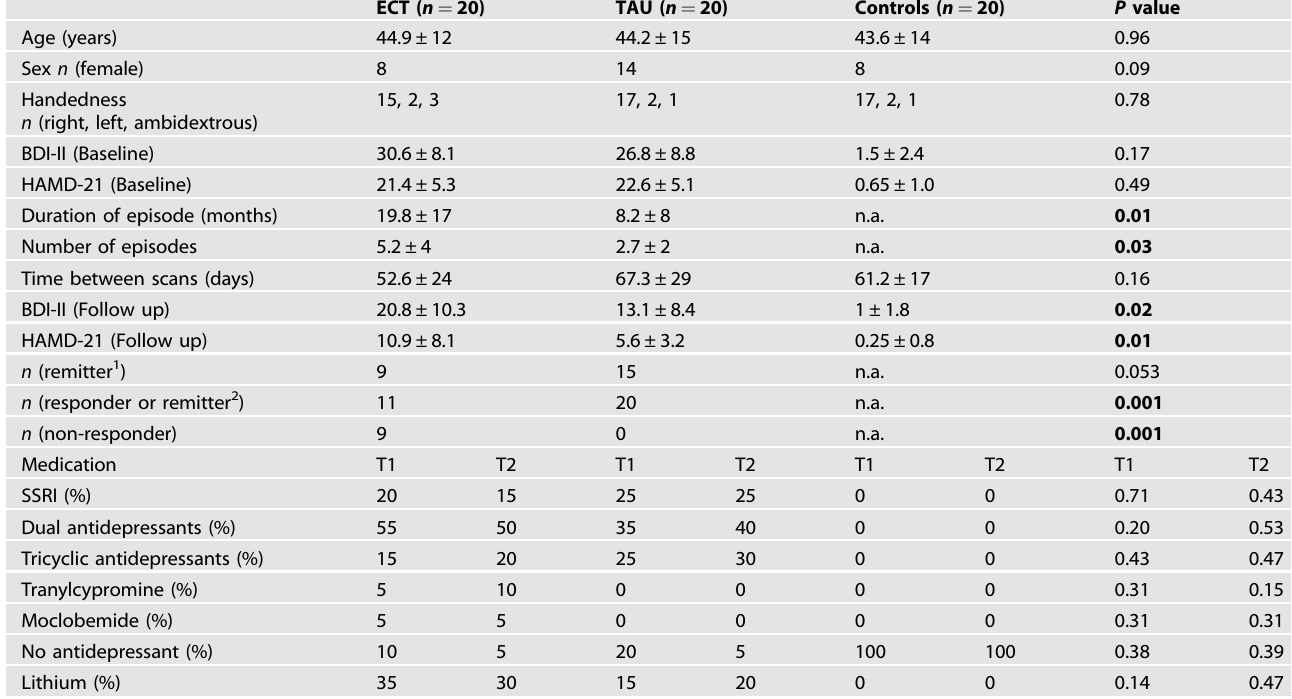
Table 1. Demographics for patients and healthy